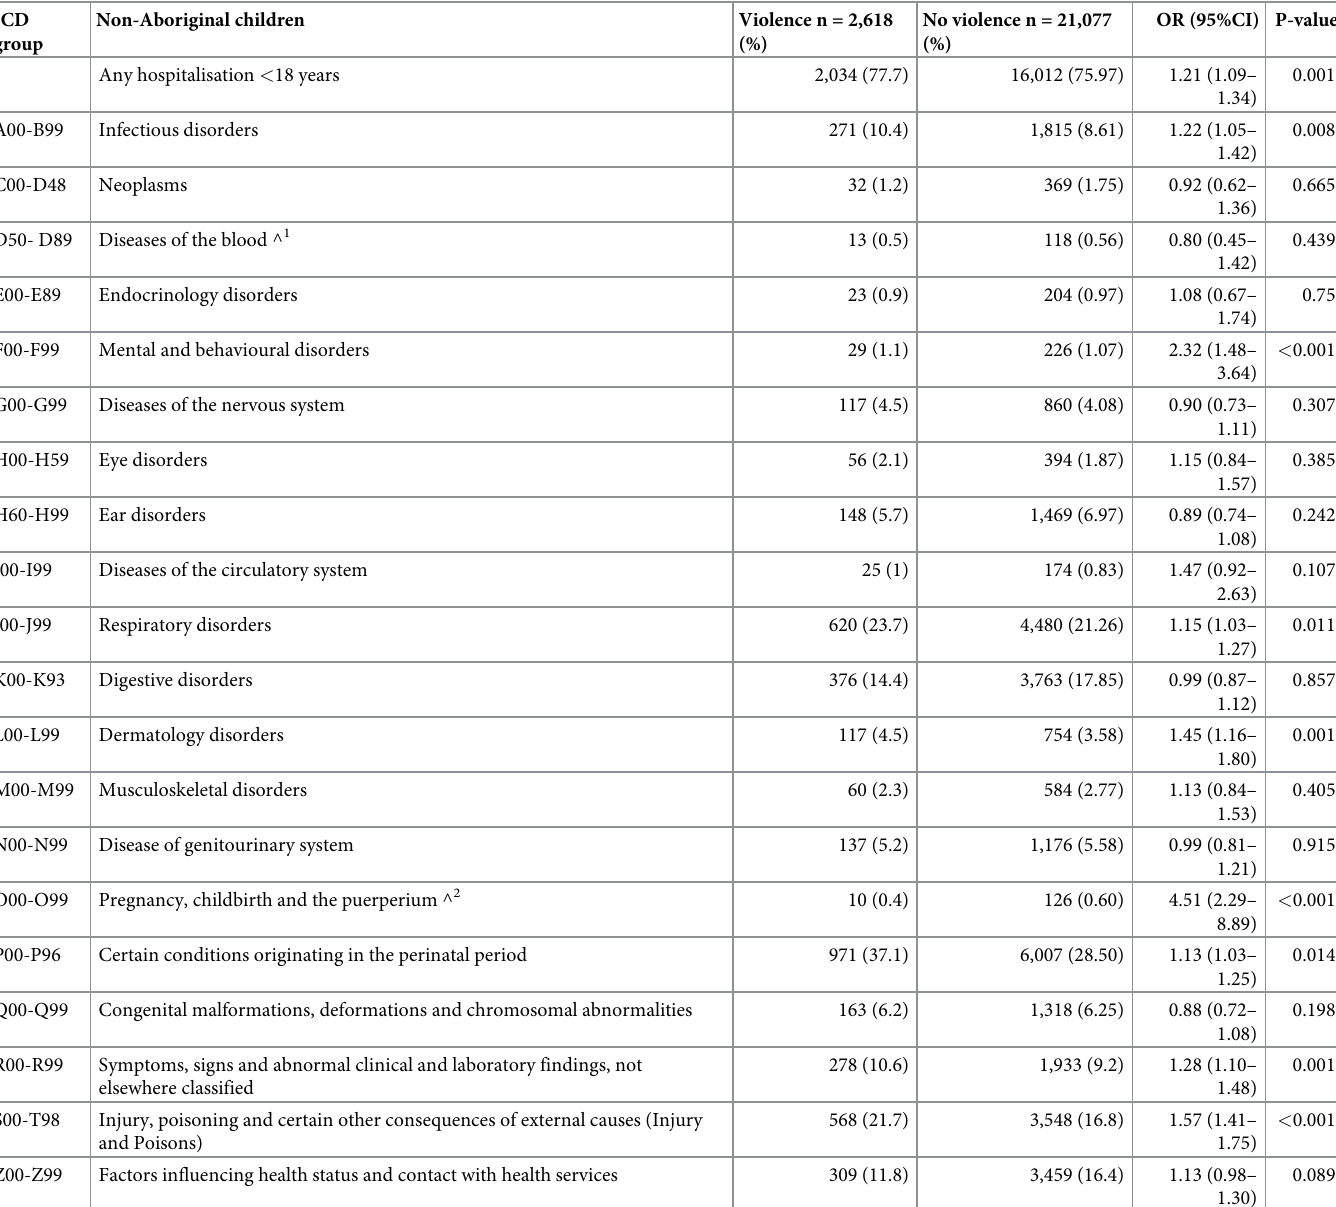
Table 4. Adjusted � principal hospitalisations for non-Aboriginal children exposed and non-exposed to FDV in early childhood period. ICD